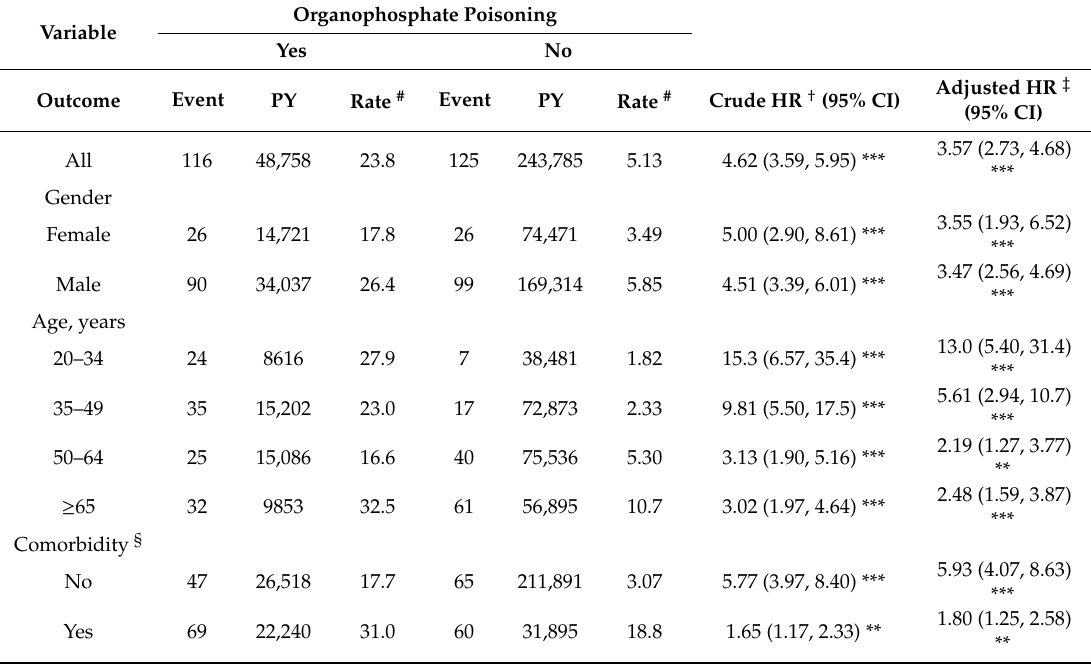
Table 2. Incidence and hazard ratio of seizures for patients with and without organophosphate poisoning.